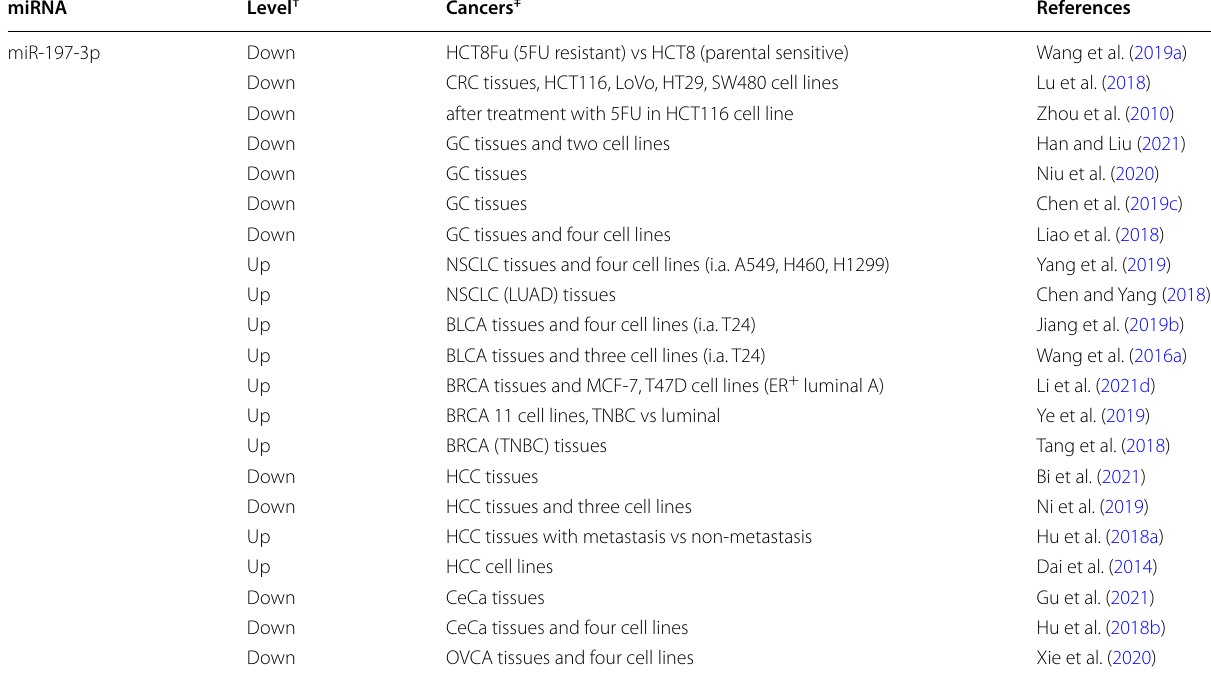
† , ‡ For description see footnote to Table 2